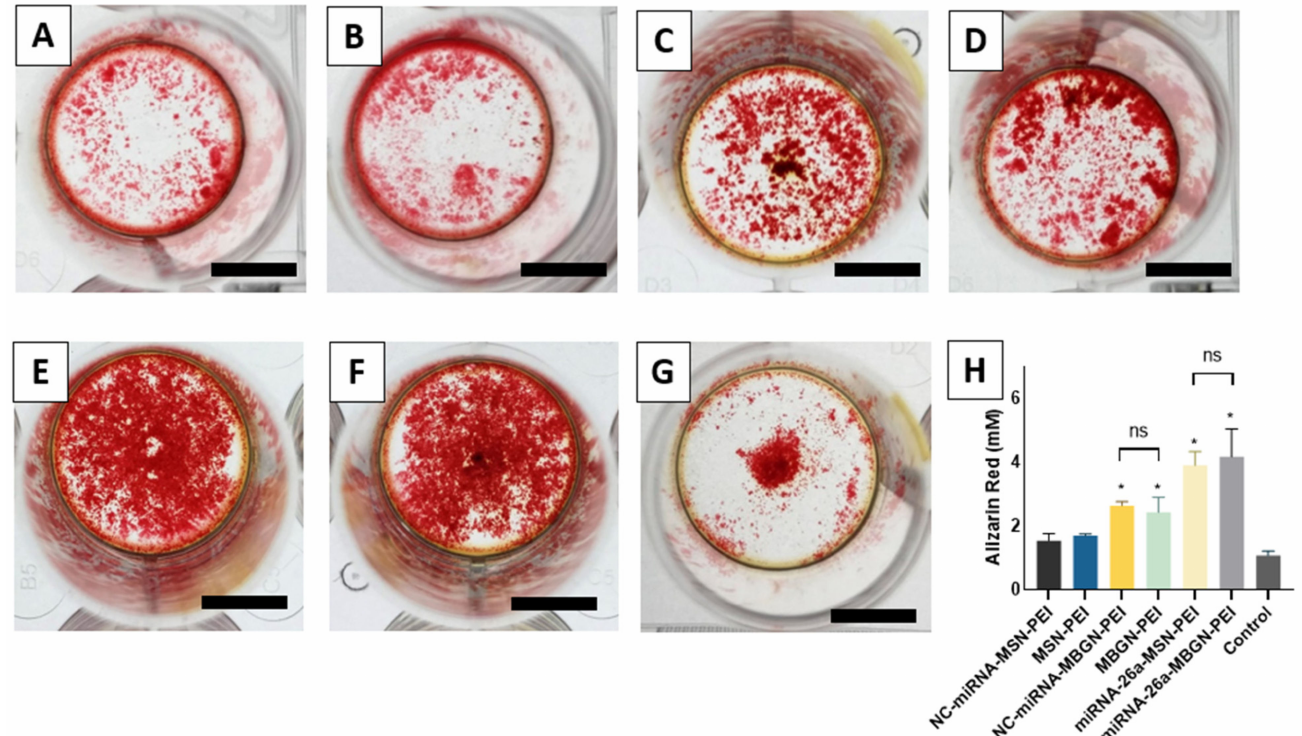
Figure 8. Mineralization and calcium secretion by BMSCs after 21 days of incubation. The cells were treated by transfected with negative control (NC)-miRNA-MSN-PEI ( A ), MSN-PEI ( B ), NC-miRNA- MBGN-PEI ( C ), MBGN-PEI ( D ), miRNA-26a-MSN-PEI ( E ), miRNA-26a-MBGN-PEI ( F ) or control ( G ) (bar = 1000 µ m). Alizarin red staining was quantified by a spectrophotometer ( H ). * p < 0.05 compared to the control group by post hoc Tukey tests ( n =